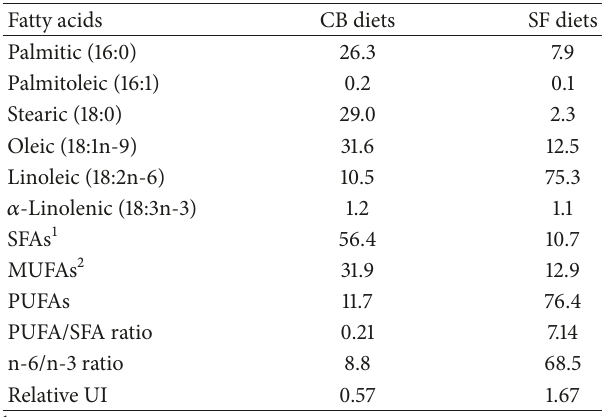
Table 1: Fatty acid composition (mol/100mol) of the experimental diets fed to weanling rats for 4 wk.